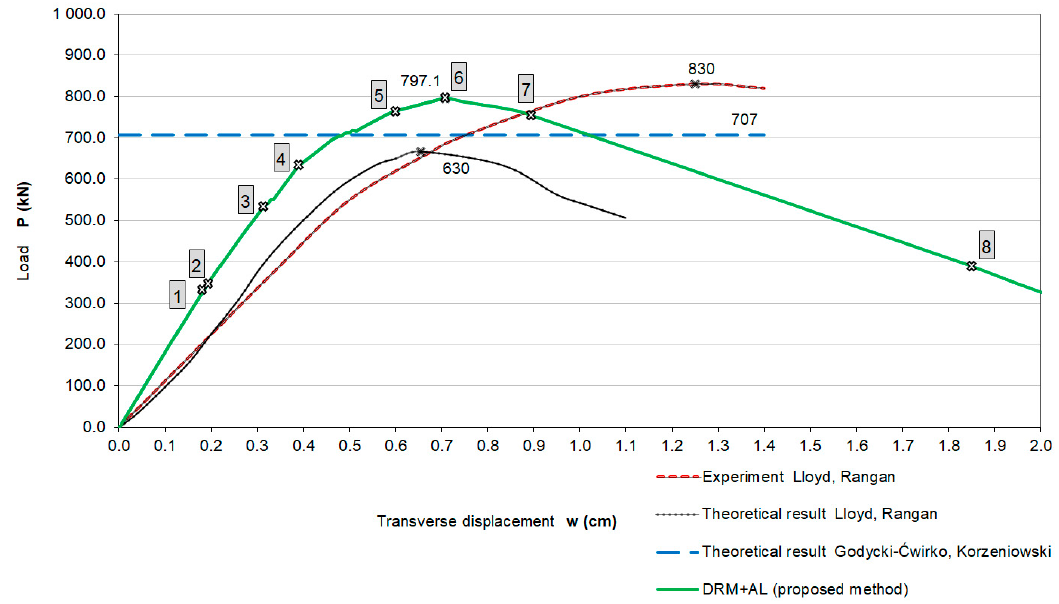
Figure 12. Numerical results for node 13 of the IB column, compared with experimental and theoretical results from Lloyd and Rangan [29] and Godycki- Ć wirko and Korzeniowski